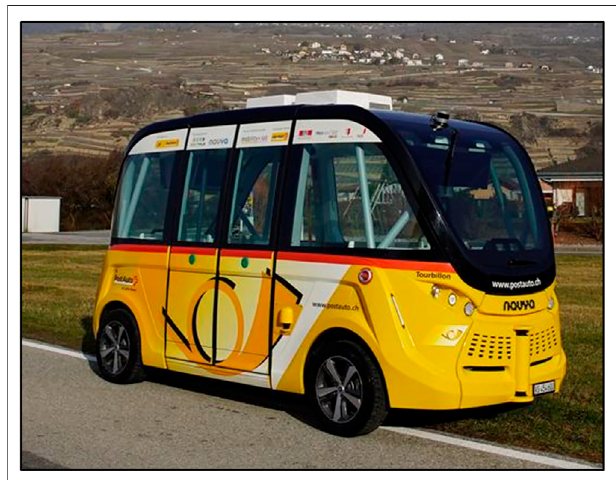
FIGURE1| AVoperatinginUvrier,aresidential quarterofthecityofSion